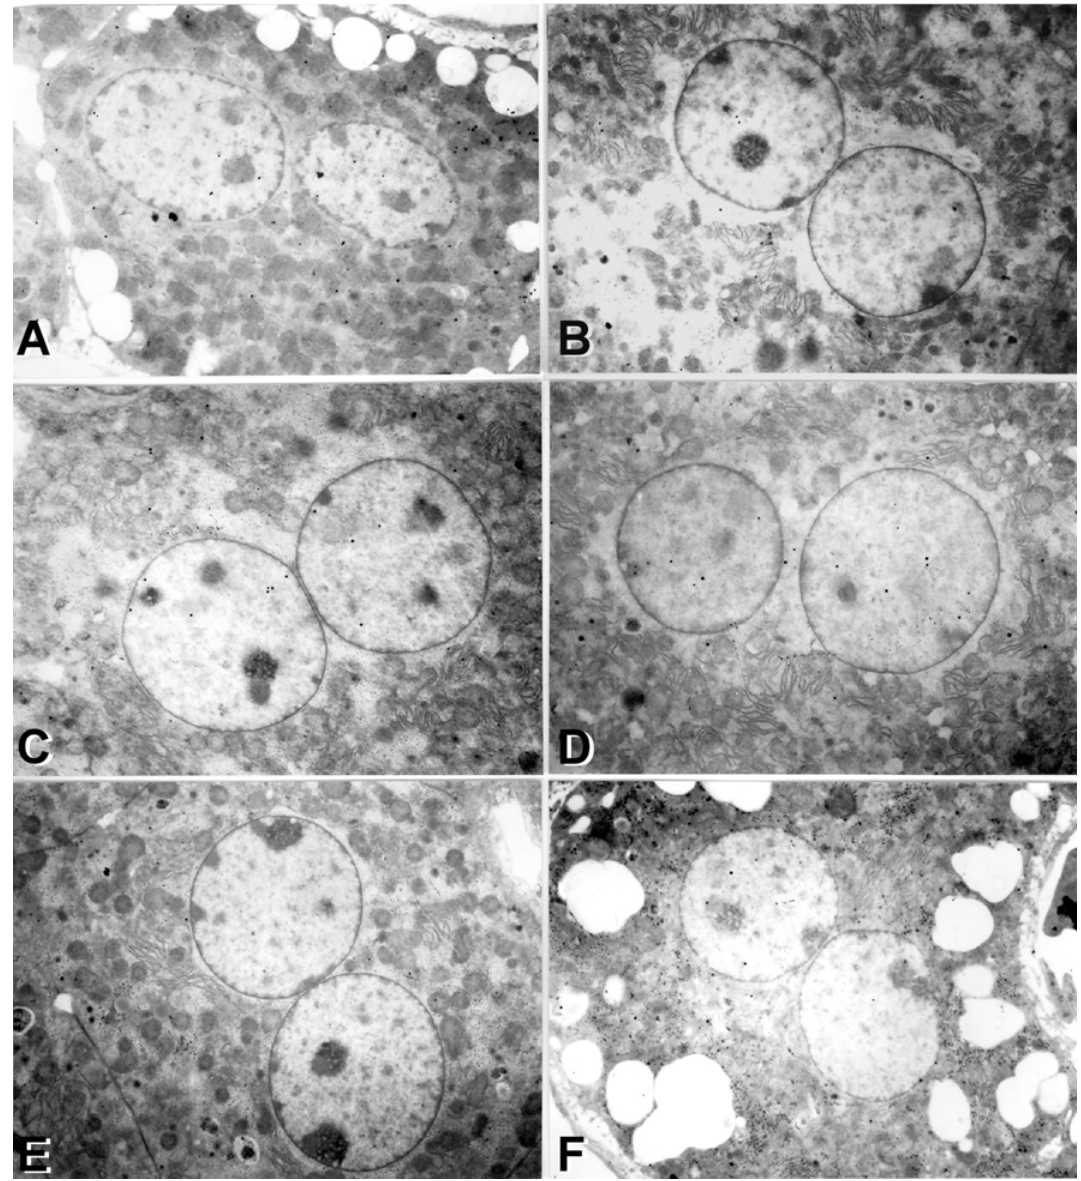
FIGURE 1 . Electron microscopic radioautograms of binucleate hepatocytes of postnatal newborn, juvenile, and young mice, labeled with 3 H-leucine, showing protein synthesis. (A) Newborn mouse aged at postnatal day 1. Note that several silver grains are observable over the mitochondrial membranes and crista of several mitochondria at right. × 5,000. (B) Suckling mouse aged at postnatal day 3. Note that a few silver grains are observable over the mitochondrial membranes and crista of a few mitochondria at right bottom. × 5,000. (C) Weanling mouse aged at postnatal day 9. Note that the paired nuclei are contacting each other and a few silver grains are observable over a few mitochondria at top left. × 5,000. (D) Weanling mouse aged at postnatal day 9. Note that the paired nuclei are separated and a few silver grains are observable over a few mitochondria at top and bottom left. × 3,000. (E) Juvenile mouse aged at postnatal day 14. Note that the paired nuclei are contacting each other and a few silver grains are observable over a few mitochondria at bottom left and right. × 5,000. (F) Young mouse aged at postnatal day 30. Note that a few silver grains are observable over a few mitochondria at bottom left. An endothelial cell can be seen at right. ×